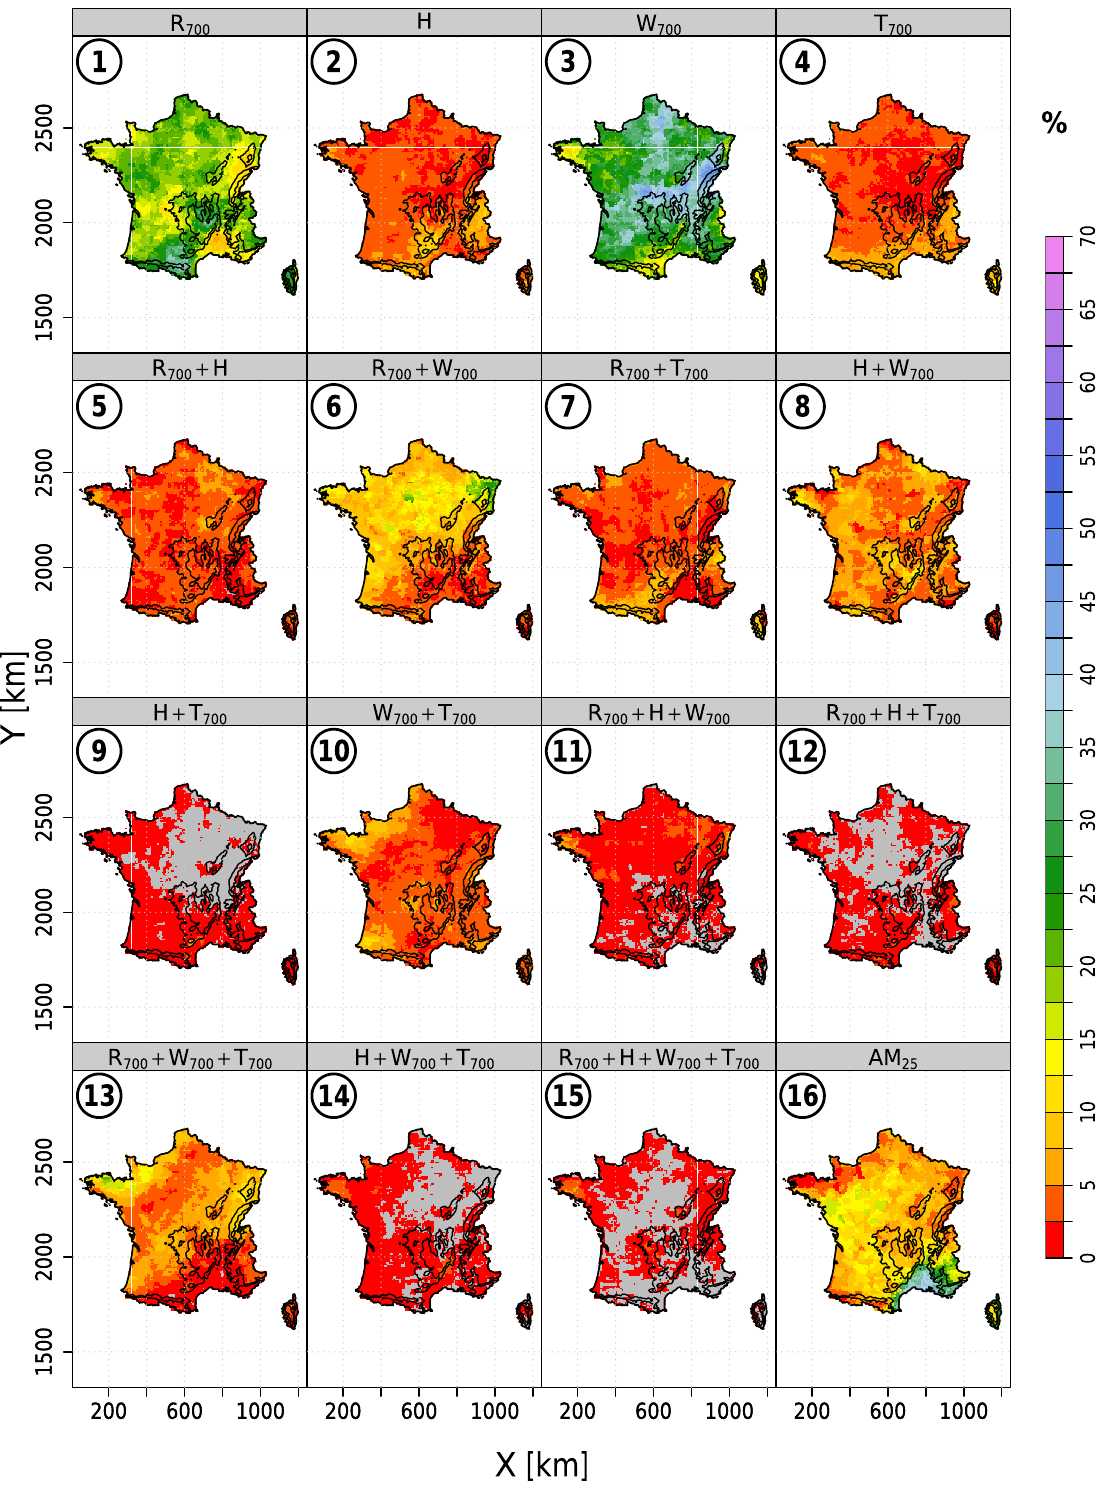
Figure 9. Same as Fig. 8 for the probabilistic prediction of precipitation amount. The selection frequency of AM 25 corresponds to the sum of those obtained for cases 1 and 2 in Fig.